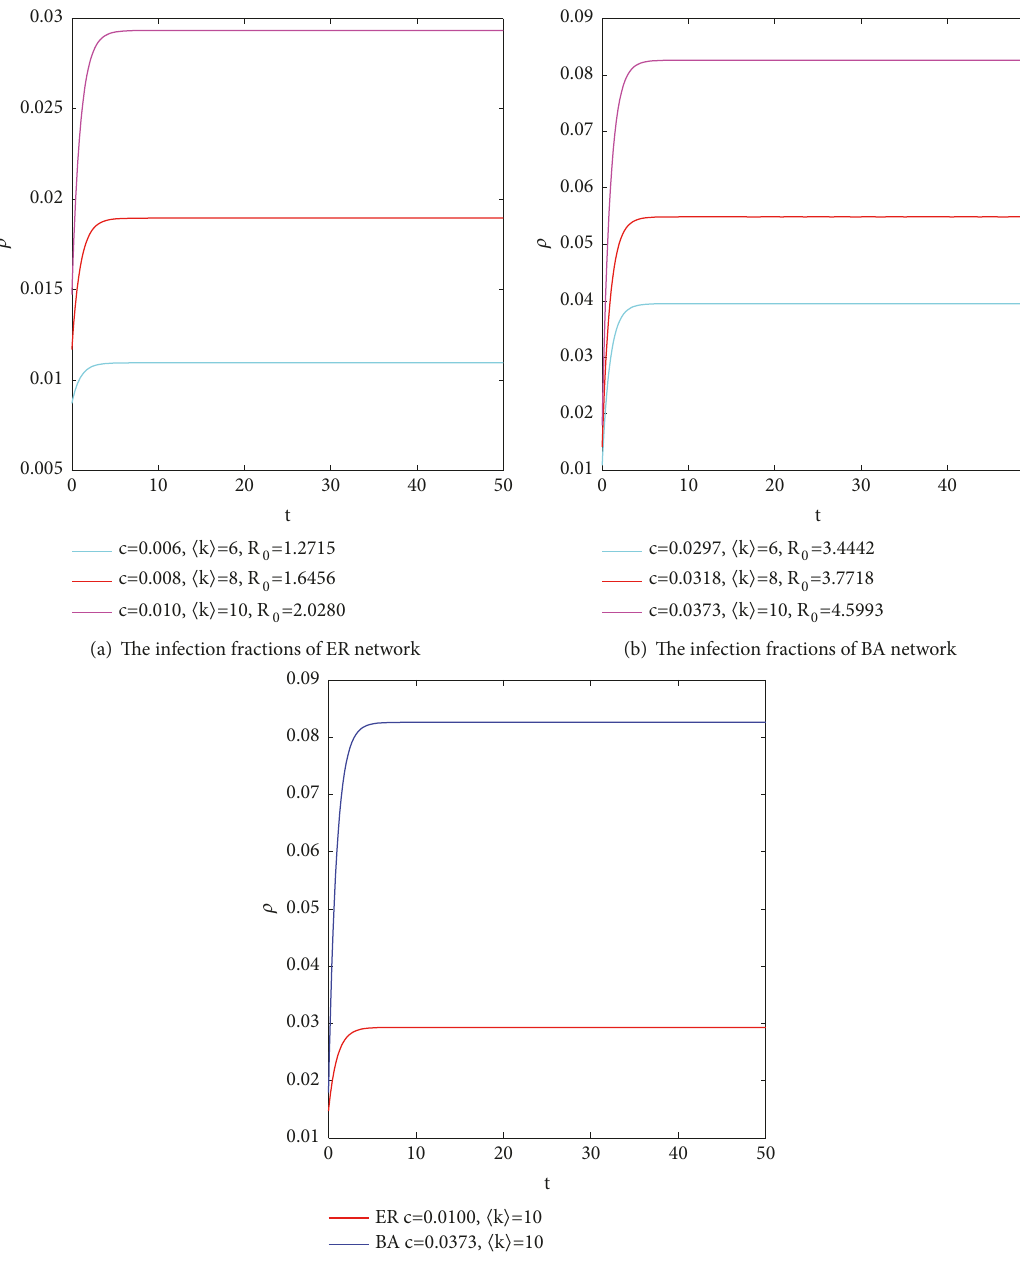
Figure 2: (a) In the ER network, the infection fractions with clustering coefficients 𝑐 = 0.006,⟨𝑘⟩ = 6 , 𝑐 = 0.008, ⟨𝑘⟩ = 8 , and 𝑐 = 0.010, ⟨𝑘⟩ = 10 are described, respectively. (b) In the BA network, the infection fractions with clustering coefficients 𝑐 = 0.0297,⟨𝑘⟩ = 6 , 𝑐 = 0.0318, ⟨𝑘⟩ = 8 , and 𝑐 = 0.0373, ⟨𝑘⟩ = 10 are described, respectively. (c) When ⟨𝑘⟩ = 10 , the infection fractions in the random network with the clustering coefficient 𝑐 = 0.01 and in the scale-free network with the clustering coefficient 𝑐 = 0.0373 are described,